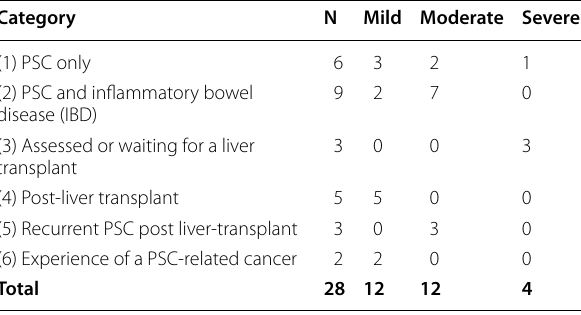
Table 5 Number of people with PSC who took part in Stage 1 discussions according to PSC category and severity Category